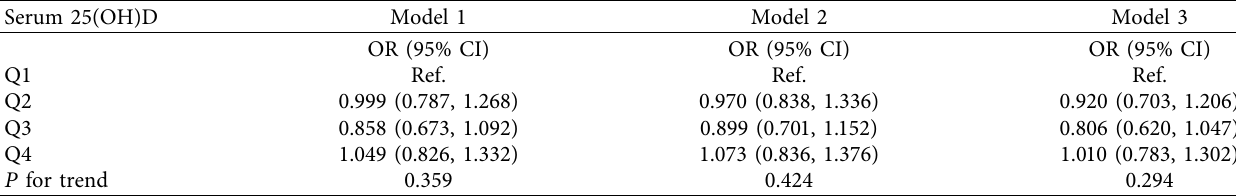
Table 2: Adjusted ORs for associations between serum 25(OH)D and the risk of AAC.